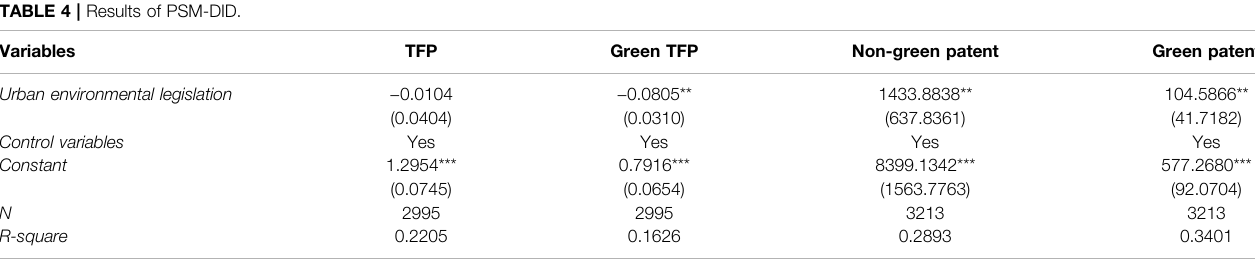
TABLE 4 | Results of